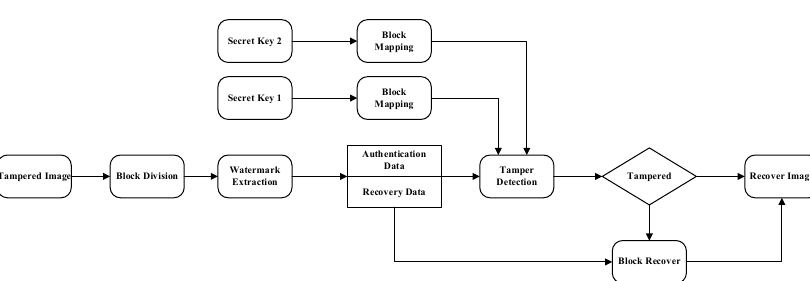
Figure 2. The watermark embedding procedure.